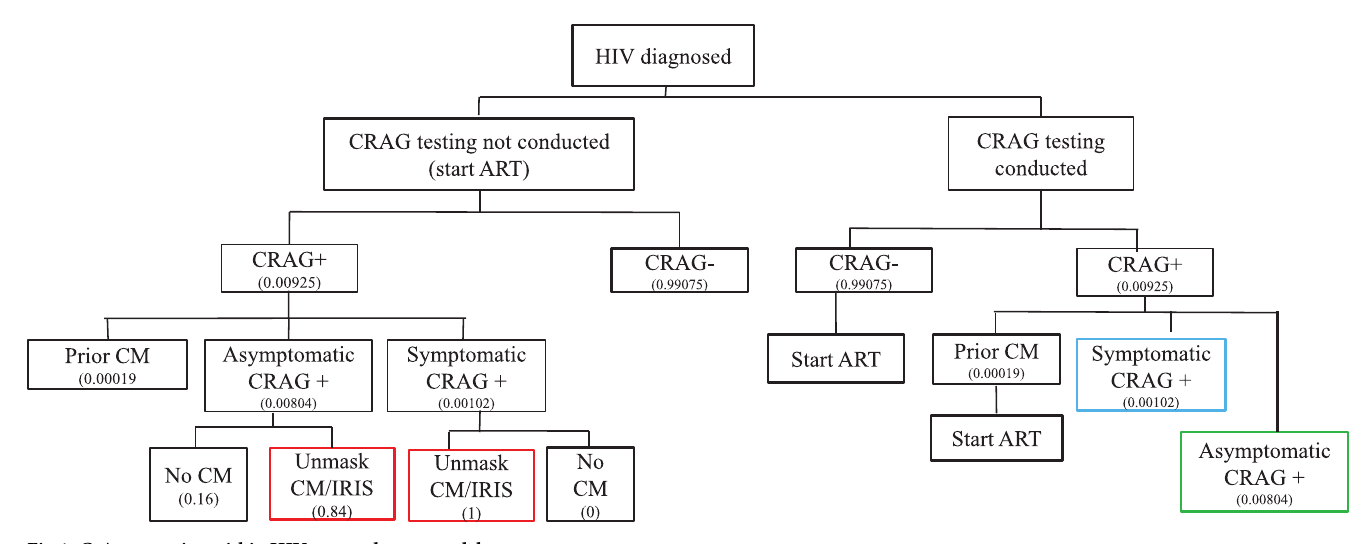
Fig 4. CrAg screening within HIV test-and-treat model.